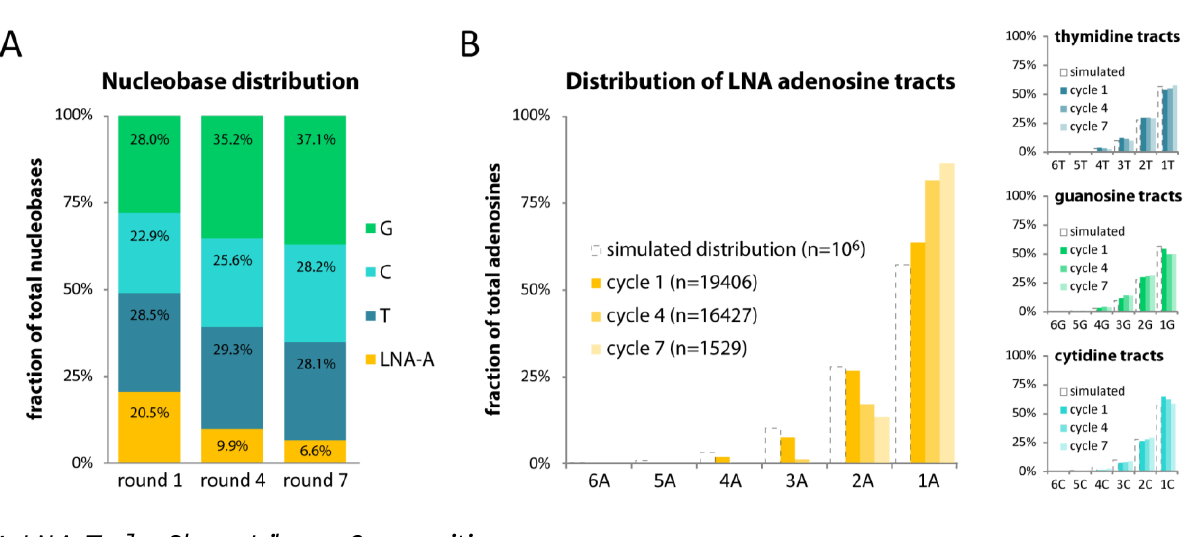
Figure 1. ( A ) Nucleobase distribution in the library’s 40-mer randomized region after one, four and seven rounds of mock in vitro selection; ( B ) The distribution of homopolymer tracts of each nucleobase in the randomized 40-mer region after one, four, and seven cycles of mock in vitro selection. Dotted bars indicate the reference distribution of tract lengths as obtained from simulating 1 million random 40-mer